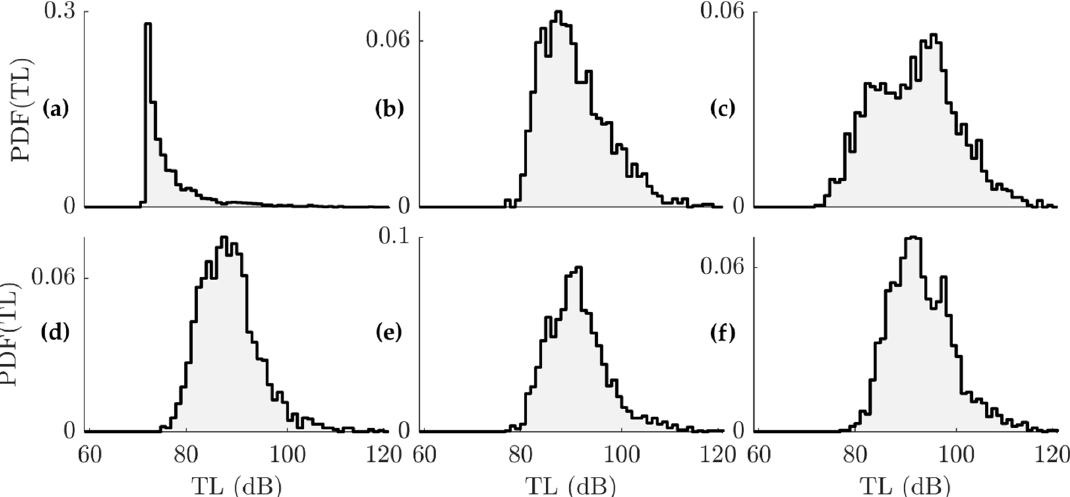
Figure 3. MC PDFs of TL for example receiver locations indicated in Figure 2. The example receiver locations corresponding to the MC PDFs of TL labeled ( a – f ) are located at ranges of 8.0, 23.3, 38.6, 53.8, 69.0, and 84.3 km and at depths near 1 km. combined into a 100-bin histogram with bin edges spanning 40 to 140 dB at 1 dB spacing. The first and last histogram bins also contained counts for any TL value less than 41 dB or greater than 139 dB respectively. The bin counts were normalized to create a discrete PDF